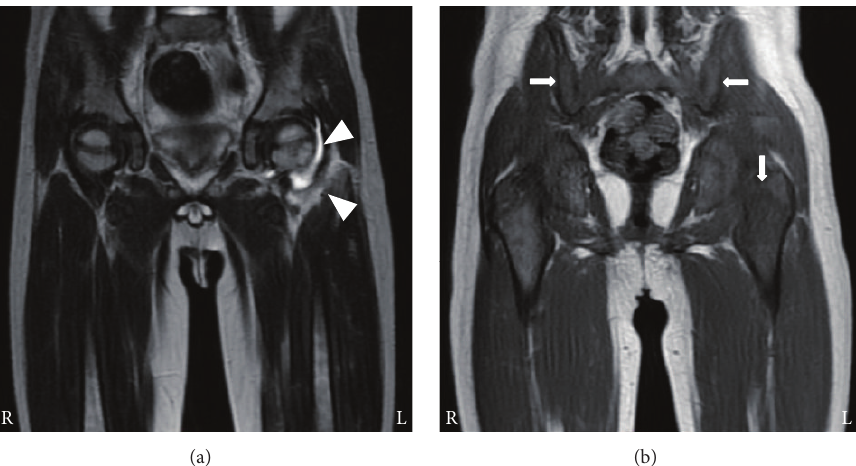
Figure 1: MRI findings in case 1. At 12 days after the disease onset, (a) T2-weighted image shows accumulation of synovial fluid and high signal intensity around the left hip joint (arrowheads) and (b) T1-weighted image depicts low signal intensity areas of the bone marrow in the ilia and the epiphysis of the left femur (arrows).